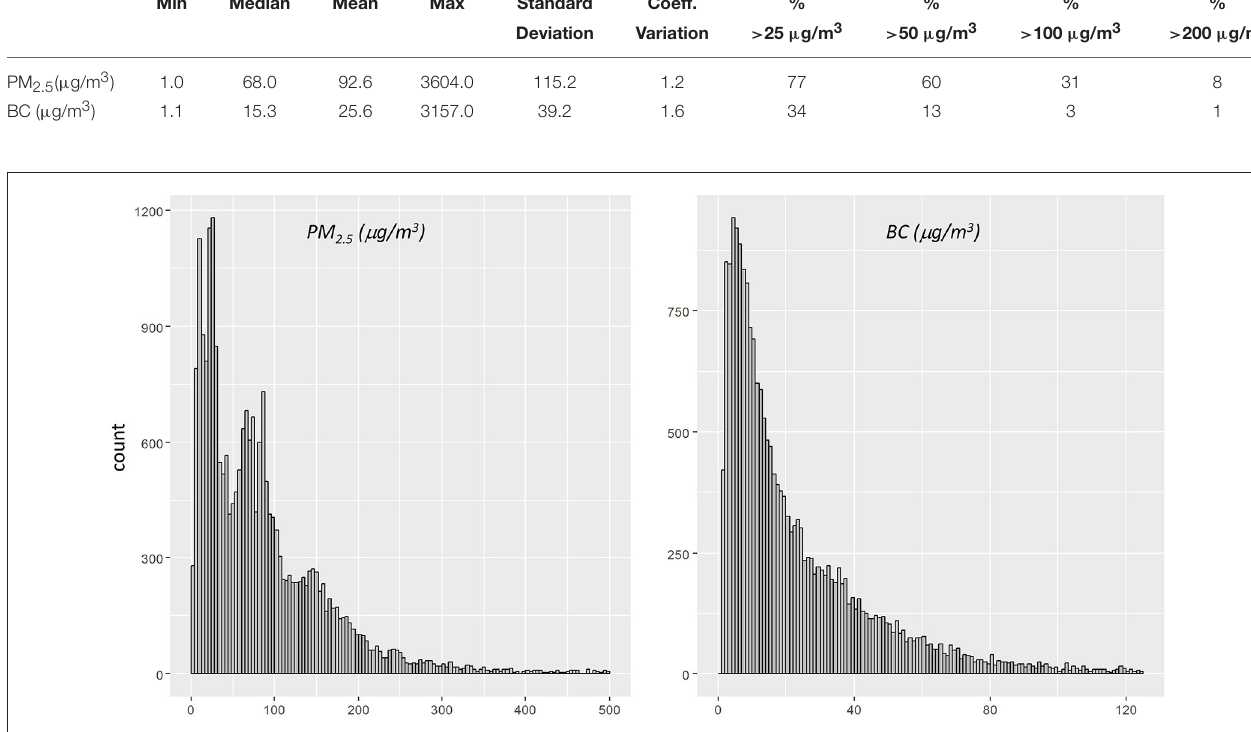
FIGURE 2 | Histograms of PM 2.5 and BC concentrations measured along the bike-paths.